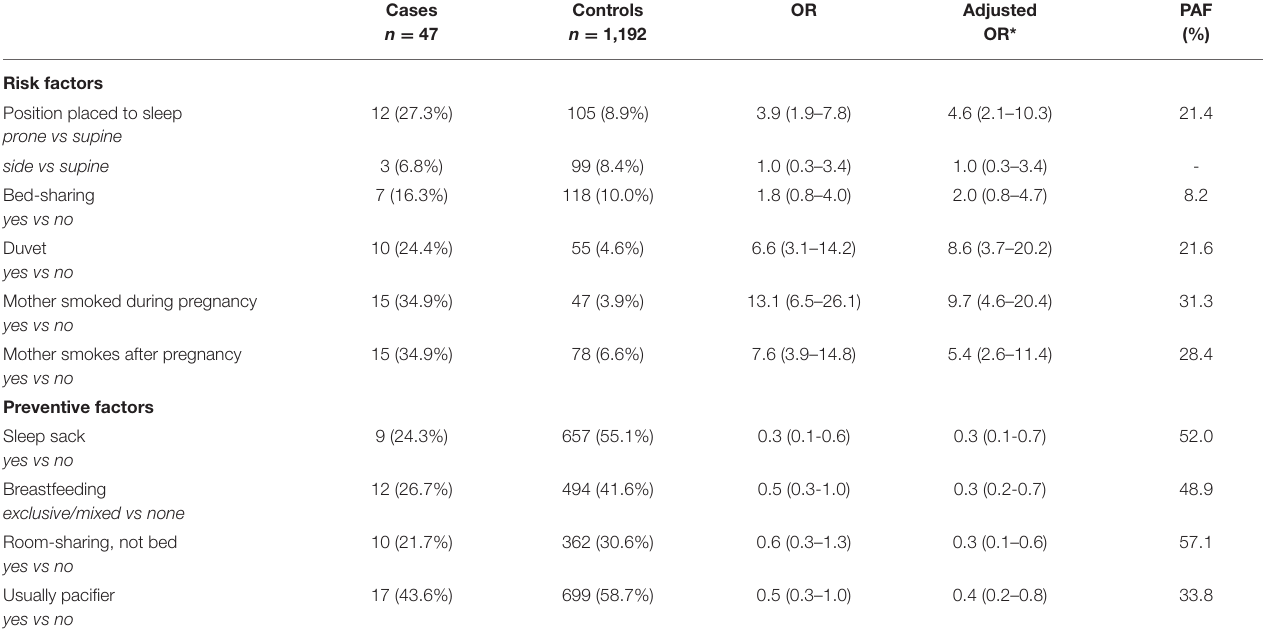
TABLE 2 | Prevalence in cases and controls of known risk and preventive factors for SUDI, Odds Ratio (OR), both crude and adjusted, and the Population Attributable Fraction (PAF) for the